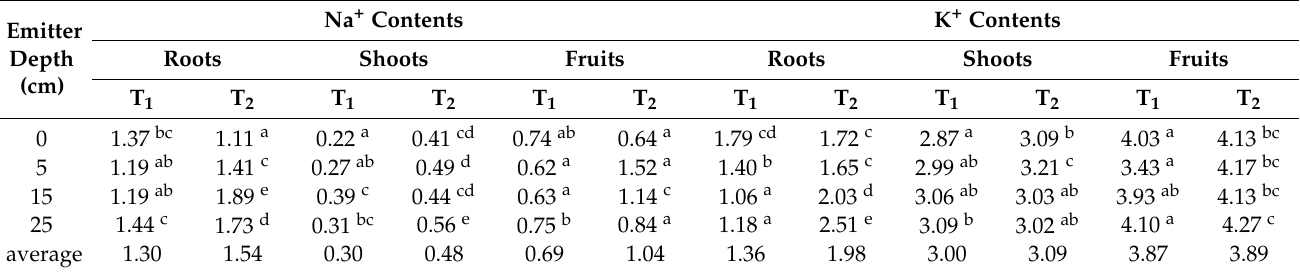
Table 6. Na + and K + concentration in roots, shoots, and fruits under different treatments (%